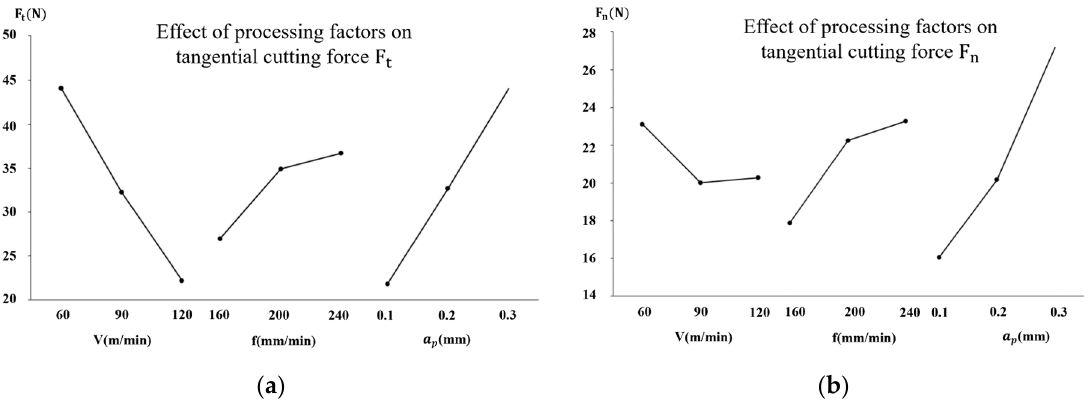
Figure 7. Effect of the level of the milling parameters on the milling force. ( a ) Tangential milling force F t . ( b ) Normal milling force F n .